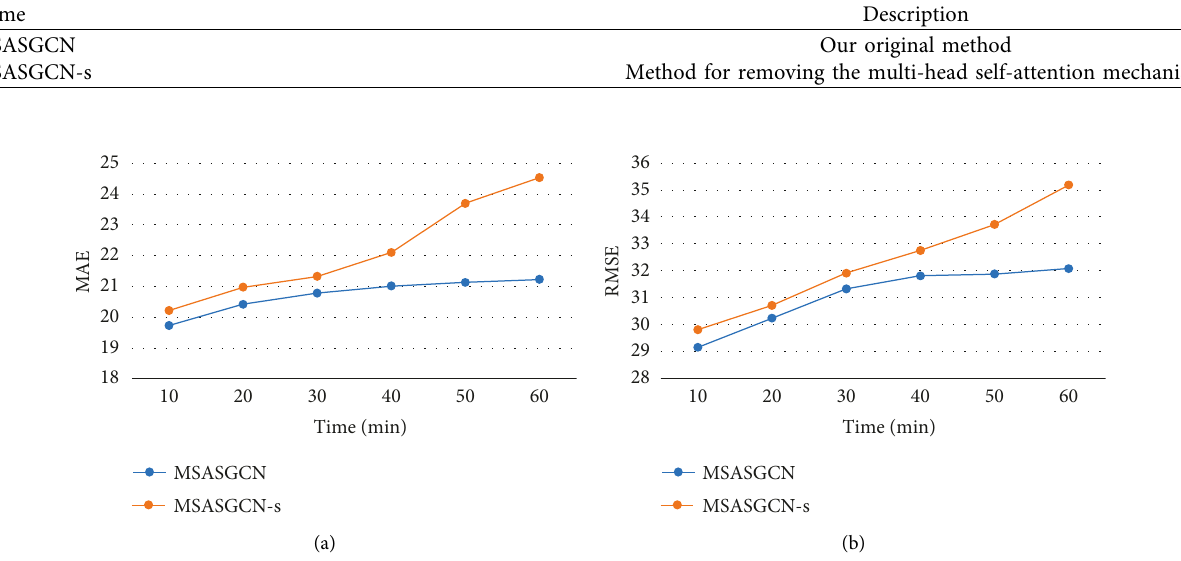
Figure 8: Module validation on the dataset PeMSD4. (a) The evolution of MAE. (b) The evolution of